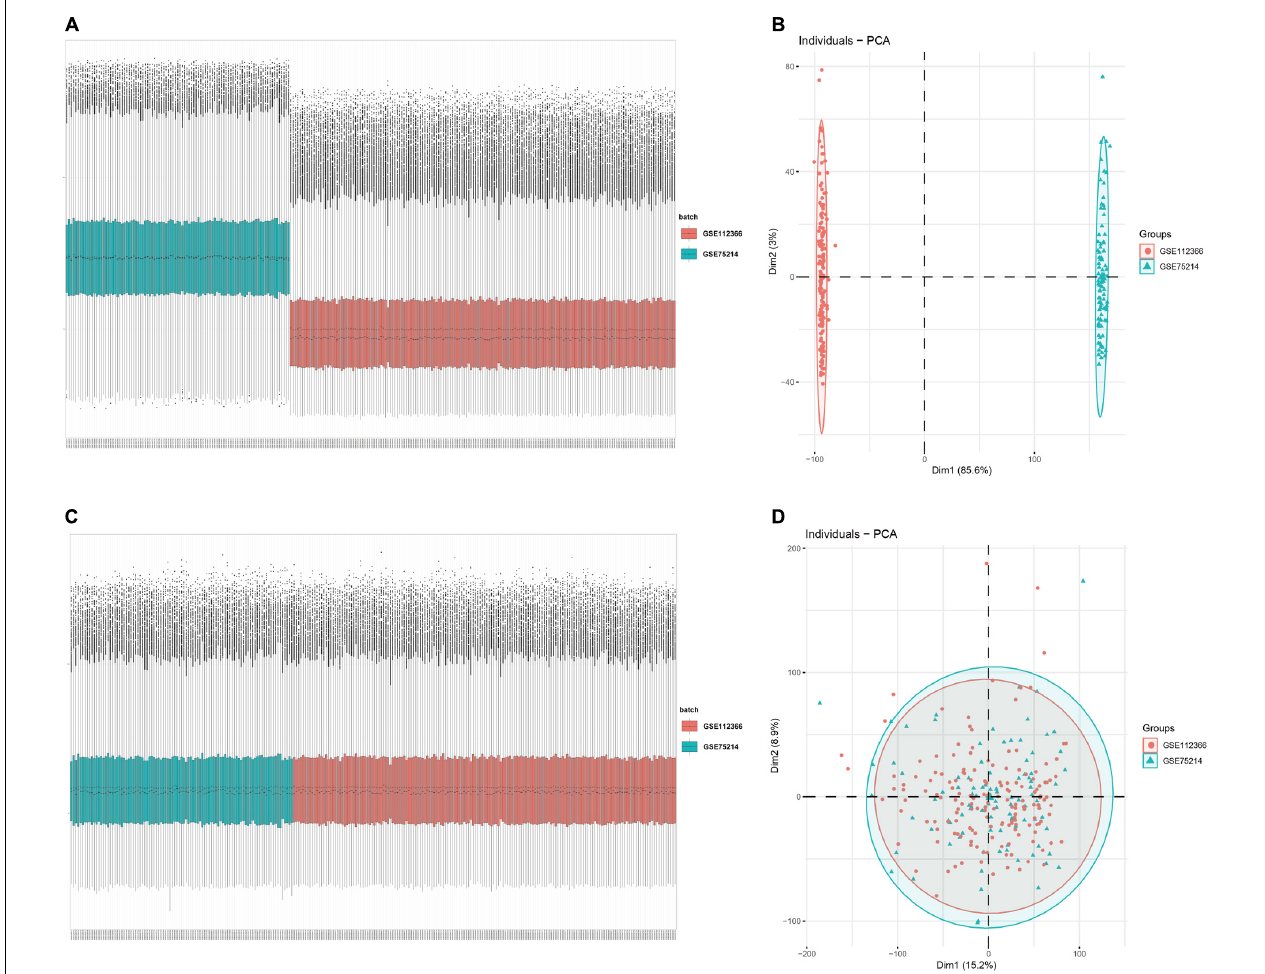
FIGURE 2 | Data preprocessing of the derivation cohort. Box plot and principal component analysis showing the overall profiles of GSE112366 and GSE75214 (A,B) before and (C,D) after normalization. The results confirmed removal of the batch effect PCA.